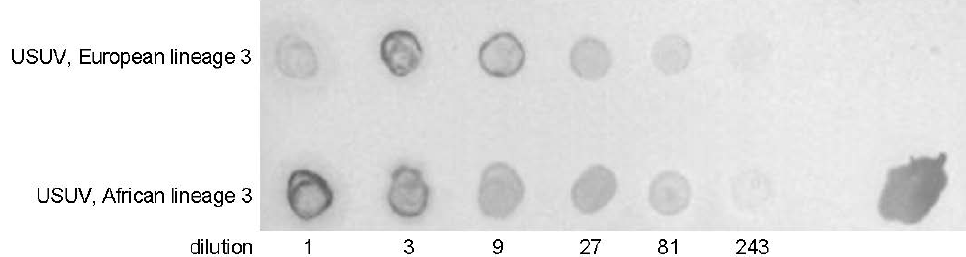
Figure 6. Dot blot of heat-inactivated supernatants of Vero cell-grown USUV strains, stained with pooled rabbit serum of USUV E protein-immunized rabbits. Upper row: USUV, European lineage 3 isolate; lower row, supernatants of USUV, African lineage 3. Supernatants were concentrated and spotted in a 1:3 dilution series. The spot to the right is a positive control, containing the immunogen ( E.coli -produced USUV E